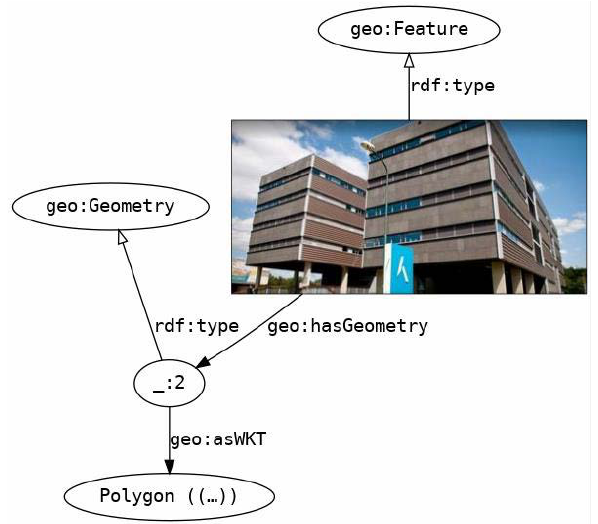
Figure 1. RDF Graph with 3D geometry Figure 1 shown an example of a small RDF graph that encodes